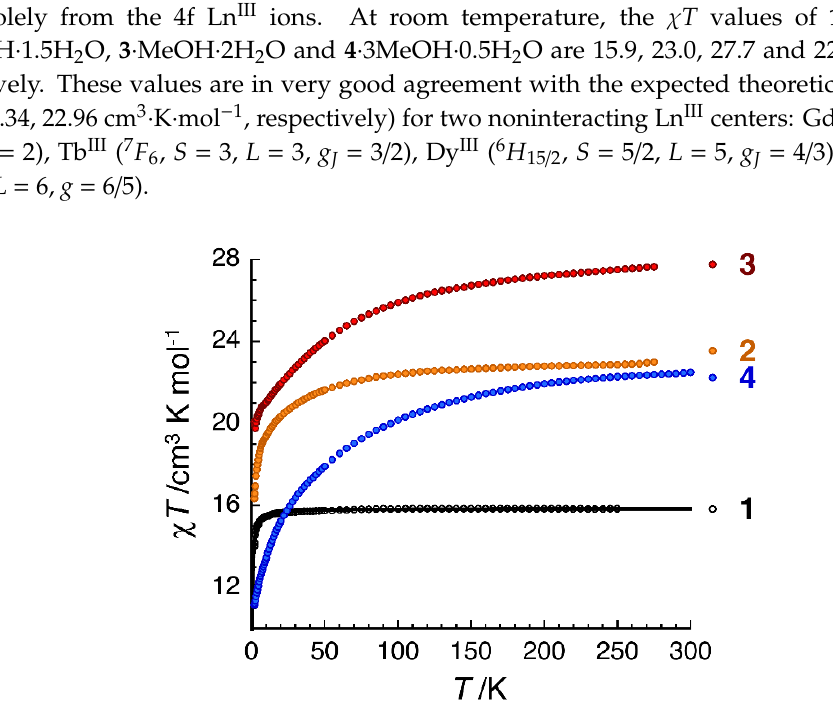
Figure 7. Temperature dependence of the χ T product for the four complexes ( 1 · 2MeOH · 2H 2 O, in black; 2 · 2MeOH · 1.5H 2 O in orange; 3 · 2.5MeOH in red and 4 · 3MeOH · 0.5H 2 O in blue) discussed in this paper at 0.1 T ( χ is defined as M / H per mole of the respective complex). The solid black line is the fit of the data to the theoretical Heisenberg model for a dinuclear Gd III 2 complex; see the text for details.